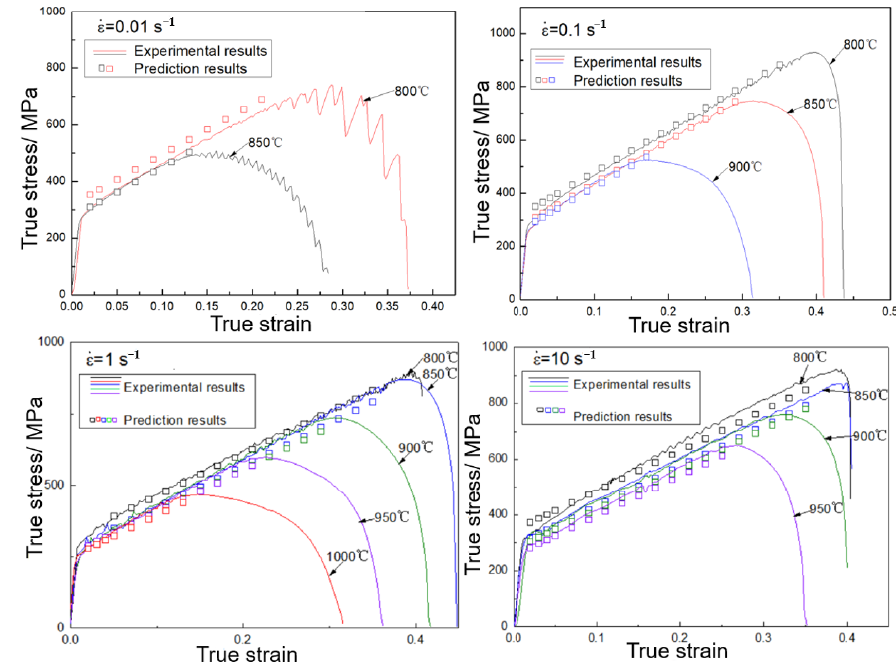
Figure 11. The prediction results of the hardening curves of WH types.